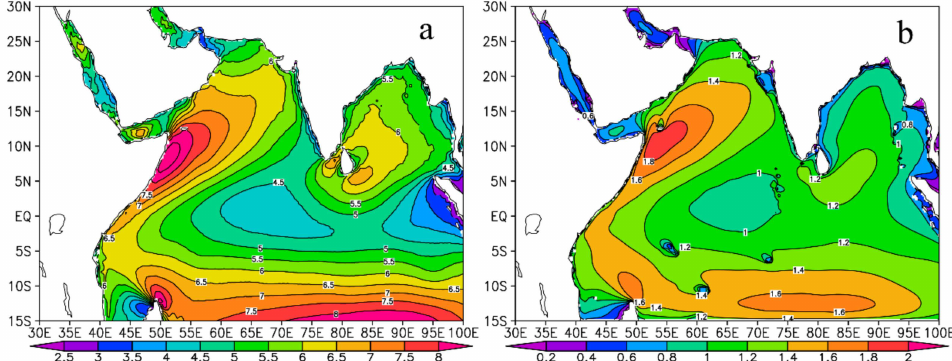
Figure 3. The distribution of 10-year average wind speed (WS) (unit: m / s) ( a ) and significant wave height (SWH) (unit: m) ( b ).